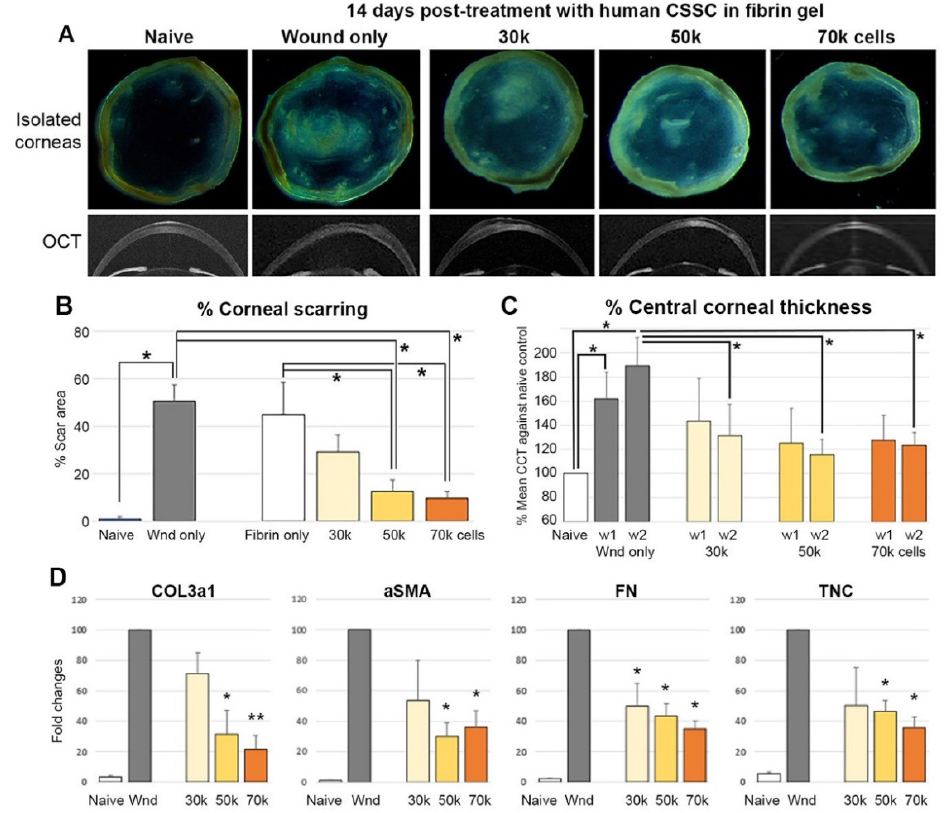
Figure 4. Treatment of CSSC in a mouse model of epithelial-stromal injury. ( A ) Isolated cornea and representative OCT images at week 2 post-injury, and cell treatment with different doses (30–70 × 10 3 cells) in fibrin gel. ( B ) A cell dose-dependent reduction in the percentage of the scar area (* p < 0.05). ( C ) The percentage of the central corneal thickness (* p < 0.05). ( D ) Fibrosis gene expression by qPCR (* p < 0.05, ** p < 0.01, compared to wound control, Mann–Whitney U